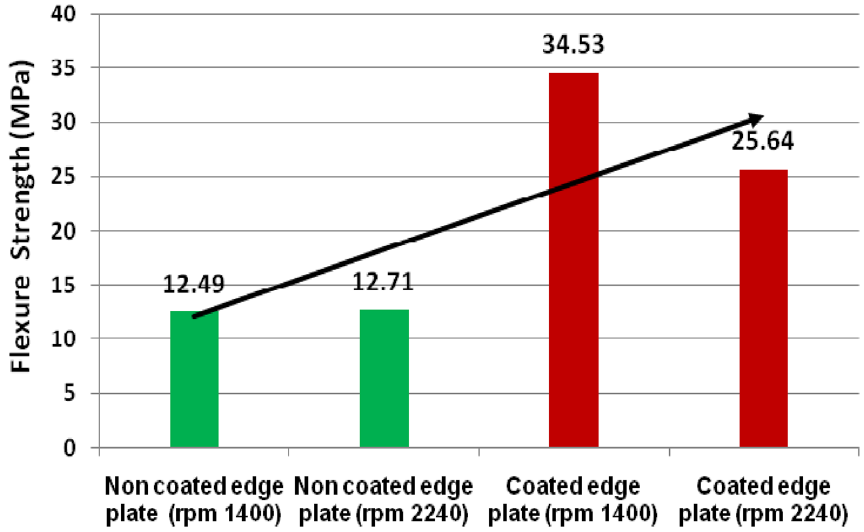
Figure 15. Flexure strength of welded joints at varying rpm.